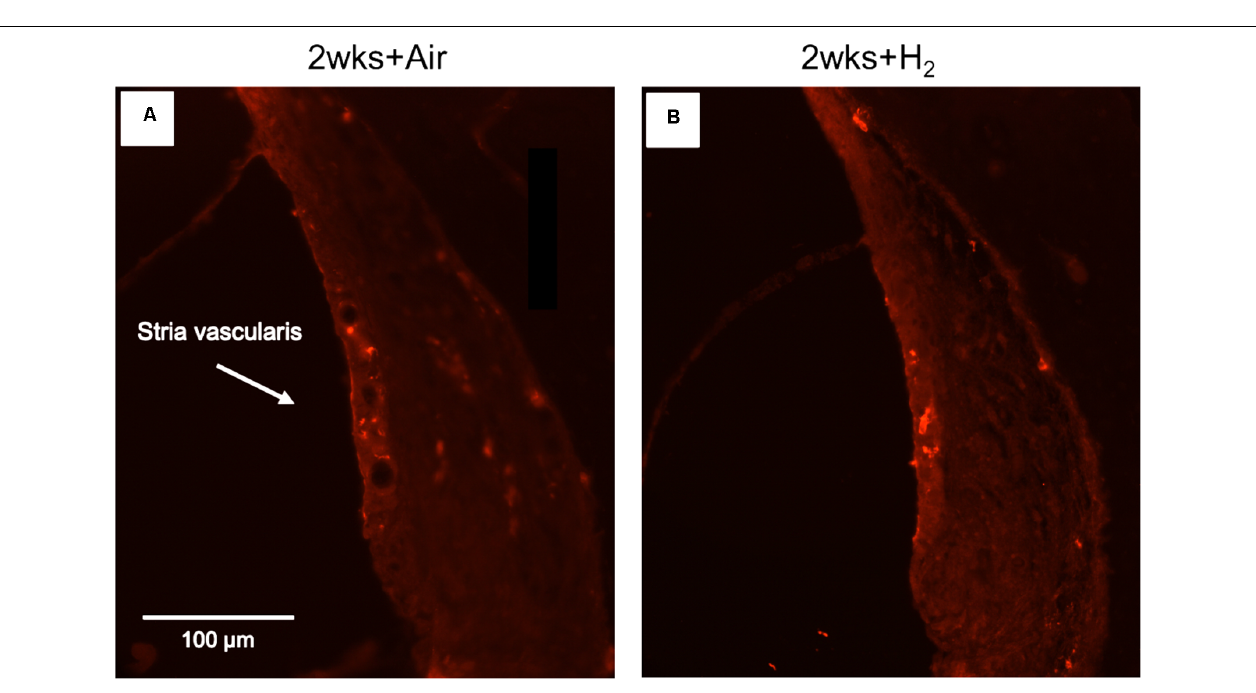
FIGURE 7 | Fluorescent image of Iba1 expression in stria vascularis in high magnification (x40). (A) Representative animal from 2w + Air. (B) Representative animal from 2w + H 2